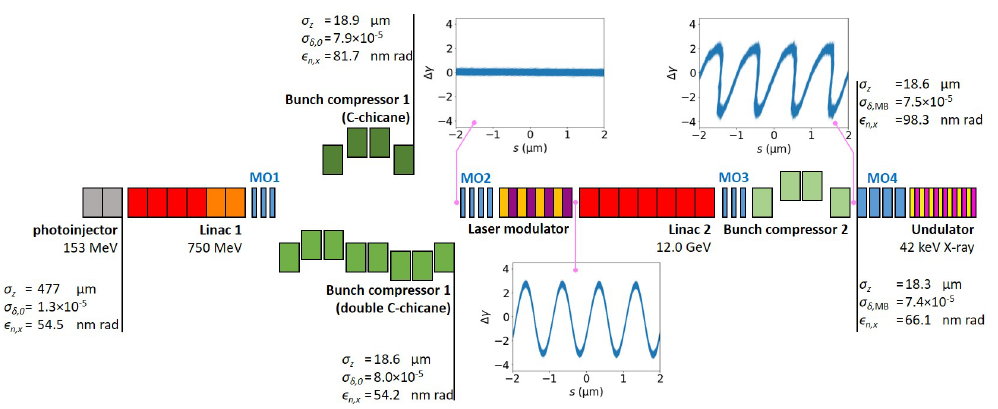
Figure 1. Schematic of the proposed MaRIE XFEL accelerator lattice using an LABC scheme for the second stage of the bunch compression. The two different configurations of the first bunch compressor (BC1) are shown. The evolution of the beam properties in lattice 1 using a conventional C-chicane as BC1 is shown at the top, and for lattice 2, which uses a double C-chicane as its BC1, is shown at the bottom. The evolution of the energy modulation, given in the variation of the Lorentz factor, is shown at the exits of BC1, the laser modulator (LM), and the second bunch compressor (BC2), explaining the development of the sequence of the high current spikes to be used for lasing in the X-ray undulator at the end of the lattice. In the figure, the instances of the matching optics (MO) are also